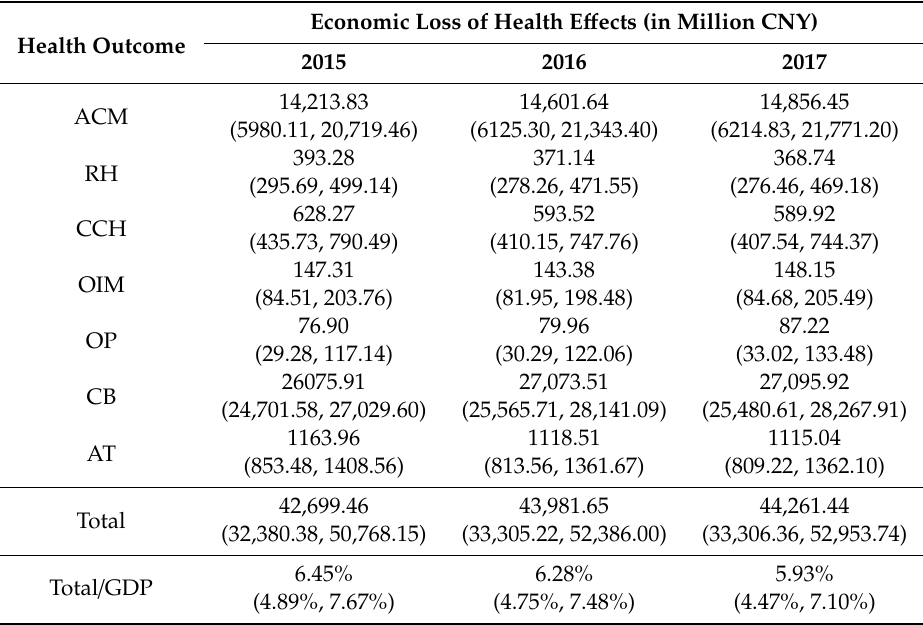
Table 3. Economic loss of PM 2.5 -related health impacts in Gansu Province from 2015 to 2017. Health